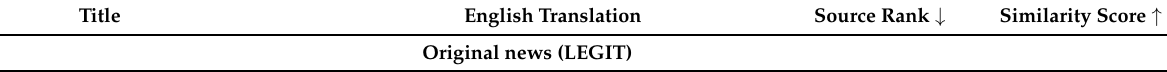
Table A2. An example of the work of the proposed approach for fake and legit news. For each target language (English, French, German, Spanish, Russian), the search results are presented: the titles of the top three news items. For every non-English title, the English translation is provided. Each piece of scraped news is rated with the rank of its source and content similarity to the original news based on text embedding. The larger (or the lower ) the score, the better. For legit news , the search ↑ ↓ results across different languages are strongly related to the original